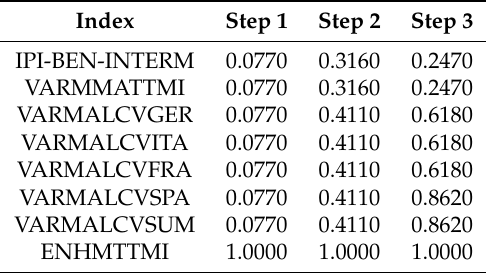
Table A26. Model confidence set hierarchy Loss function is squared error at the end of the sample for intermediate goods model comparison α = 0.05, number of bootstrap replications = 5000 and block length = 12. The null hypothesis is that the average performance of the model in the row is as small as the minimum average performance across the remaining models. The alternative is that the minimum average loss across the remaining models is smaller than the average performance of the model in the row.